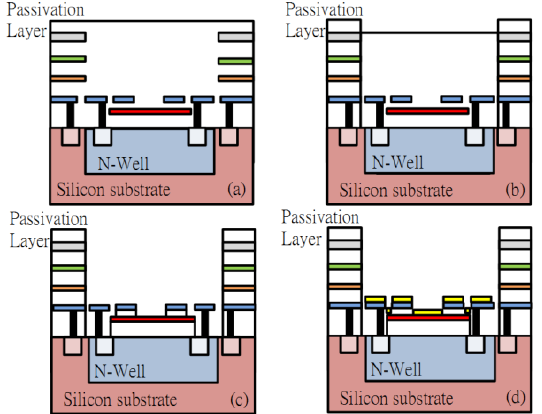
Figure 4. Fabrication process ( a ) after-standard TSMC 0.35- μ m CMOS process ( b ) removal of passivation layer ( c ) RLS etch ( d ) gold